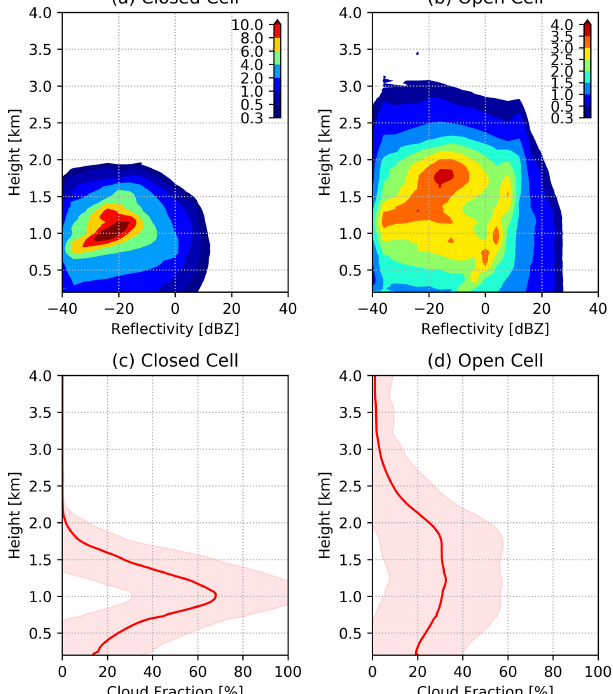
Figure 7. Contoured frequency by altitude diagrams (CFAD) of radar reflectivity for (a) open-cell and (b) closed-cell cases. Ver- tical profiles of hourly cloud fraction from ARSCL for (c) open-cell and closed-cell cases. Lines are means; shadings are 1 σ standard deviations. Figure 8. Histograms of (a) LWP, (b) PWV, (c) cloud top height,